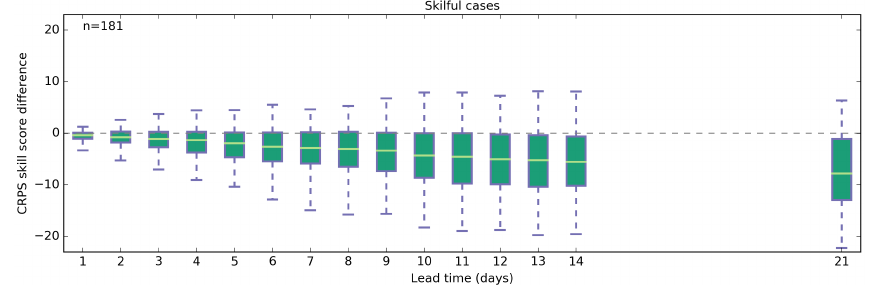
Figure 9. As for Fig. 8 except considering only cases where the 0-day-lead-time forecast is skilful (CRPS skill score > 5).